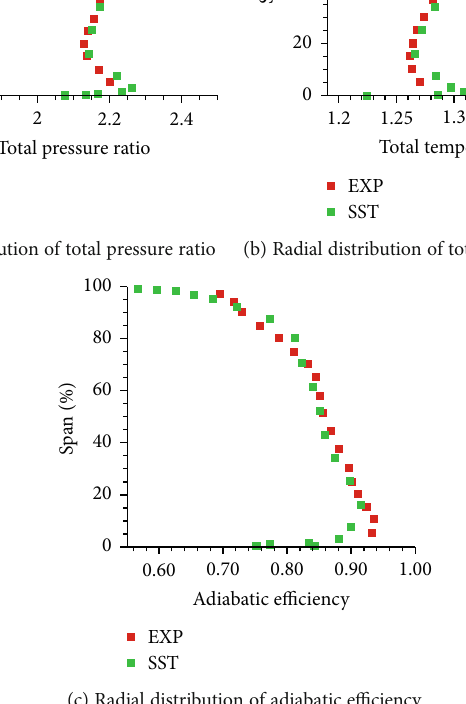
Figure 12: Computational and experimental spanwise distributions of total pressure ratio, total temperature ratio and adiabatic e ffi ciency at near stall